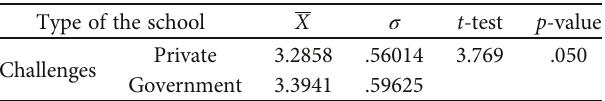
T ABLE 8: Independent samples t -test on challenges for ICT integra- tion in secondary